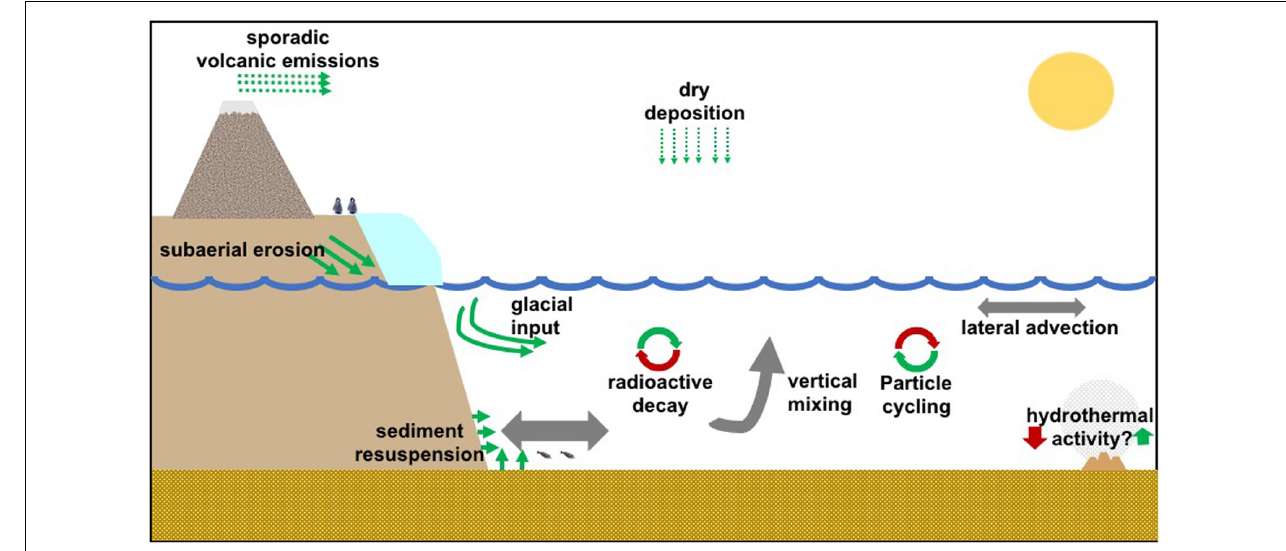
FIGURE 7 | Possible sources (green arrows), sinks (red arrows), and transport vectors (gray arrows) of thorium isotopes and other trace elements to the waters of the Kerguelen